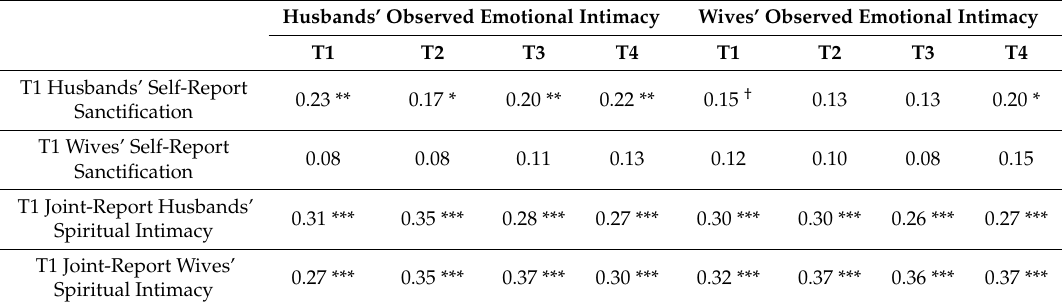
Table 2. Bivariate Correlations between Major Study Variables at Each Time